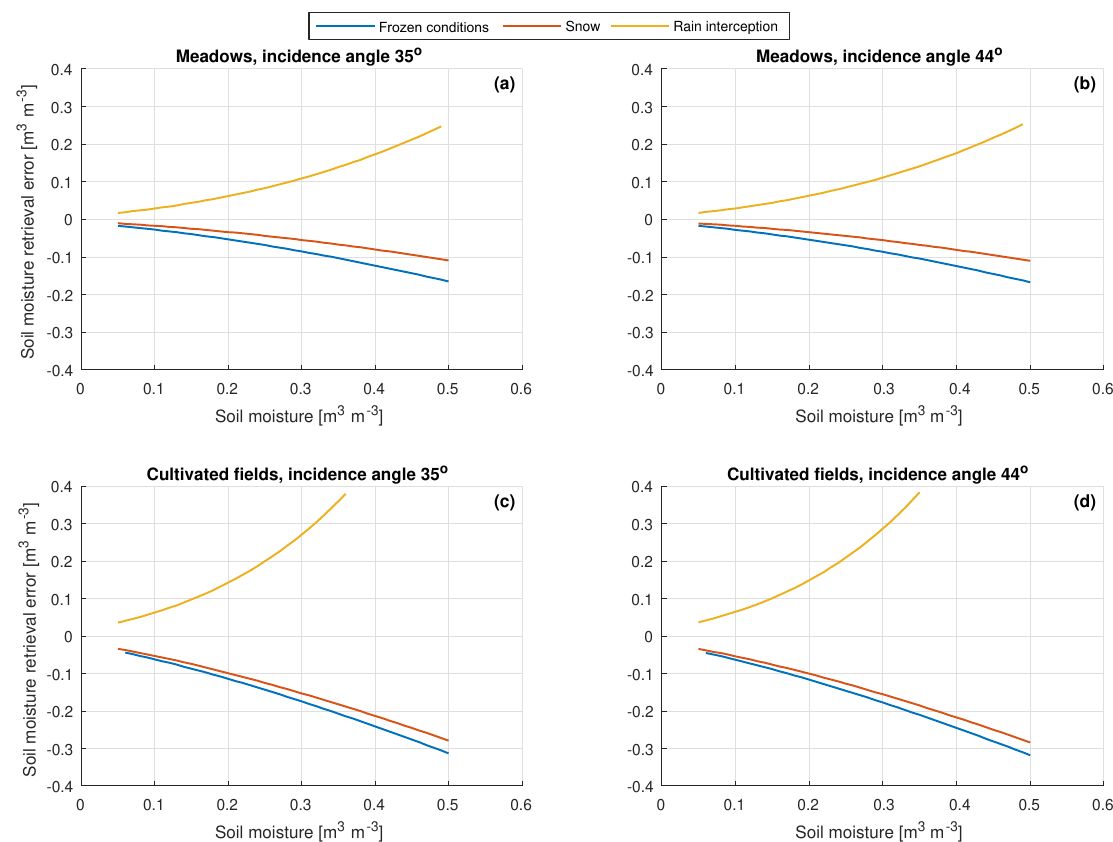
Figure 11. Impacts of frozen conditions, snow and rain interception on soil moisture retrieved from Sentinel-1 VV σ 0 , for an incidence angle of 35 ◦ on meadows ( a ), 44 ◦ on meadows ( b ), 35 ◦ on cultivated fields ( c ) and 44 ◦ on cultivated fields ( d ). For the effects of frozen conditions, snow and rain interception on Sentinel-1 σ 0 , the mean effects listed in Table 4 are taken.